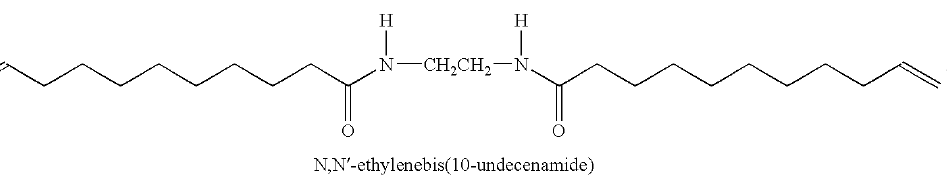
Figure 2. The structure of as synthesized EBU [12].